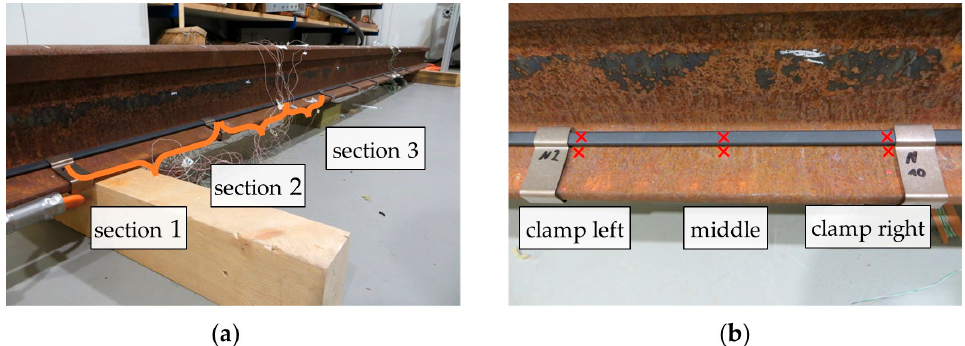
Figure 15. ( a ) Stock rail with eight sections (three of them marked) consisting of two heating rod clamps and heating rod in between; ( b ) Section with temperature measurement spots (marked by red crosses) at clamp left, middle, and clamp right.